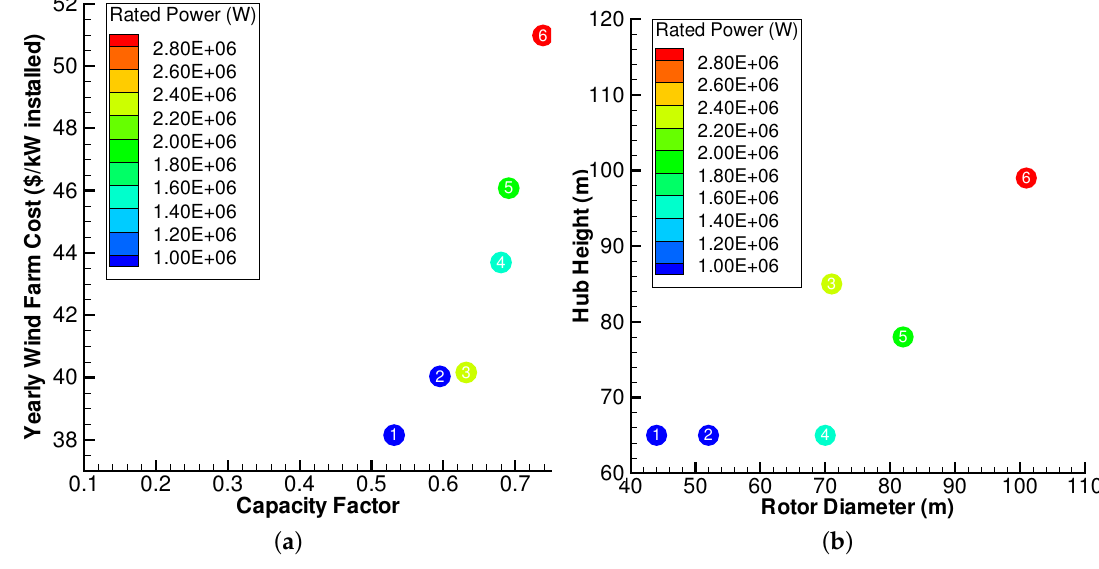
Figure 19. Tradeoffs offered by the best performing turbines of different rated powers for Case VI: Class 6–7 winds. ( a ) Best tradeoffs between the capacity factor and average annual cost ($/kW installed); ( b ) rotor diameters and hub heights of the best tradeoff